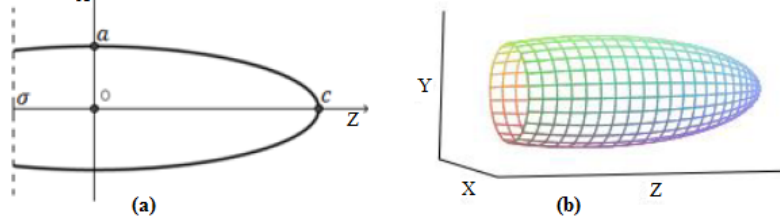
Figure 2. The geometry of the TPS, considered to be similar to the LV’s